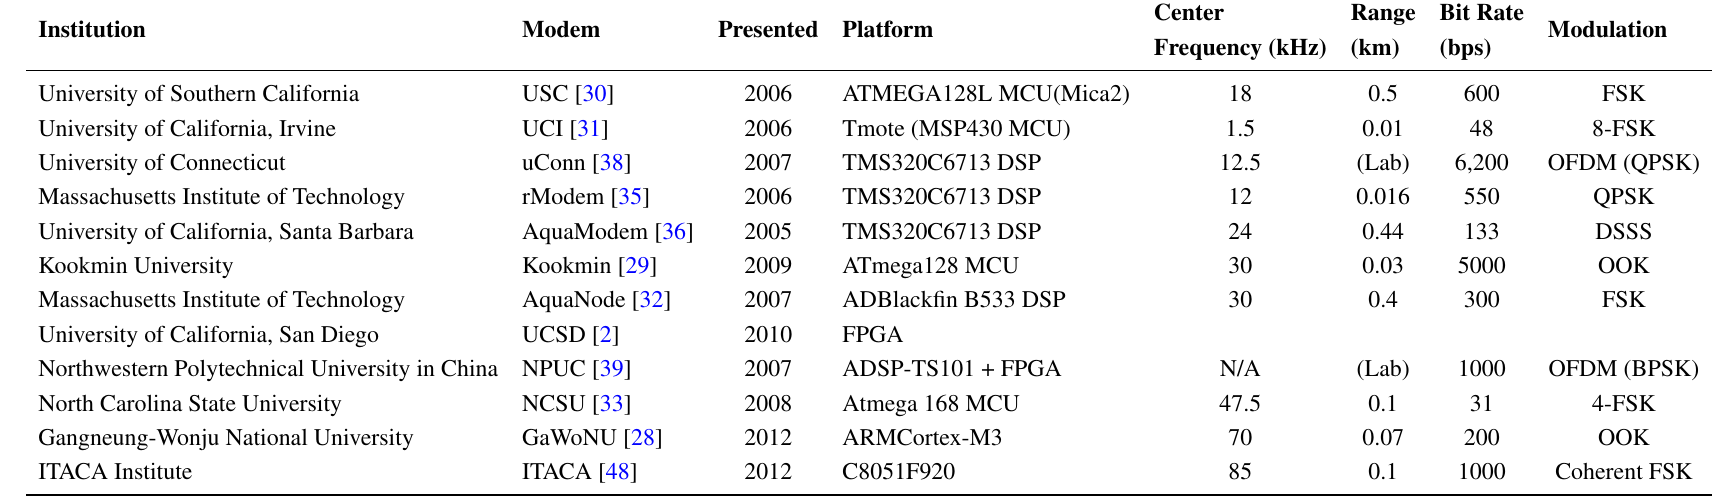
Table 2. Comparison of research modems. OFDM, orthogonal frequency-division multiplexing; DSSS, direct-sequence spread-spectrum; OOK, on-off